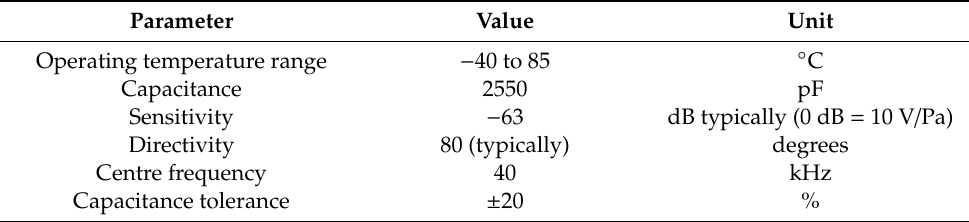
Figure 1. Schematic of an ultrasonic transducer. Table 2. Ultrasonic transducer